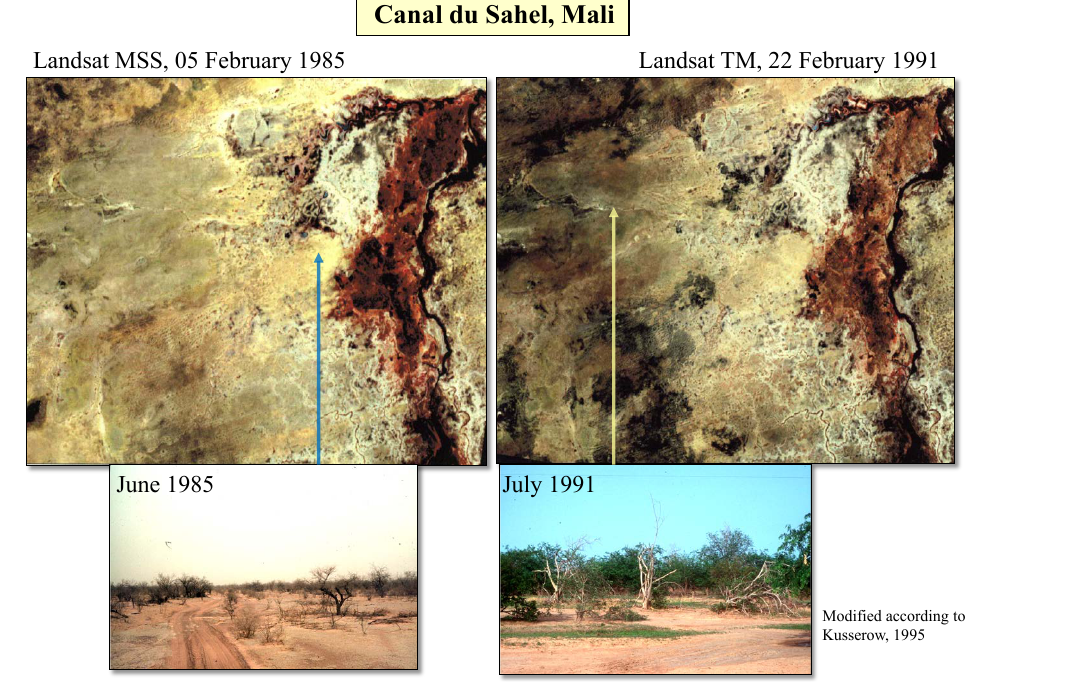
Figure 11. Satellite images from the Canal du Sahel region in Mali show the situation during the drought period (February 1985; see also the view from the ground, June 1985) and during the so-called re-greening (February 1991; size of subset is approx. 70km ×